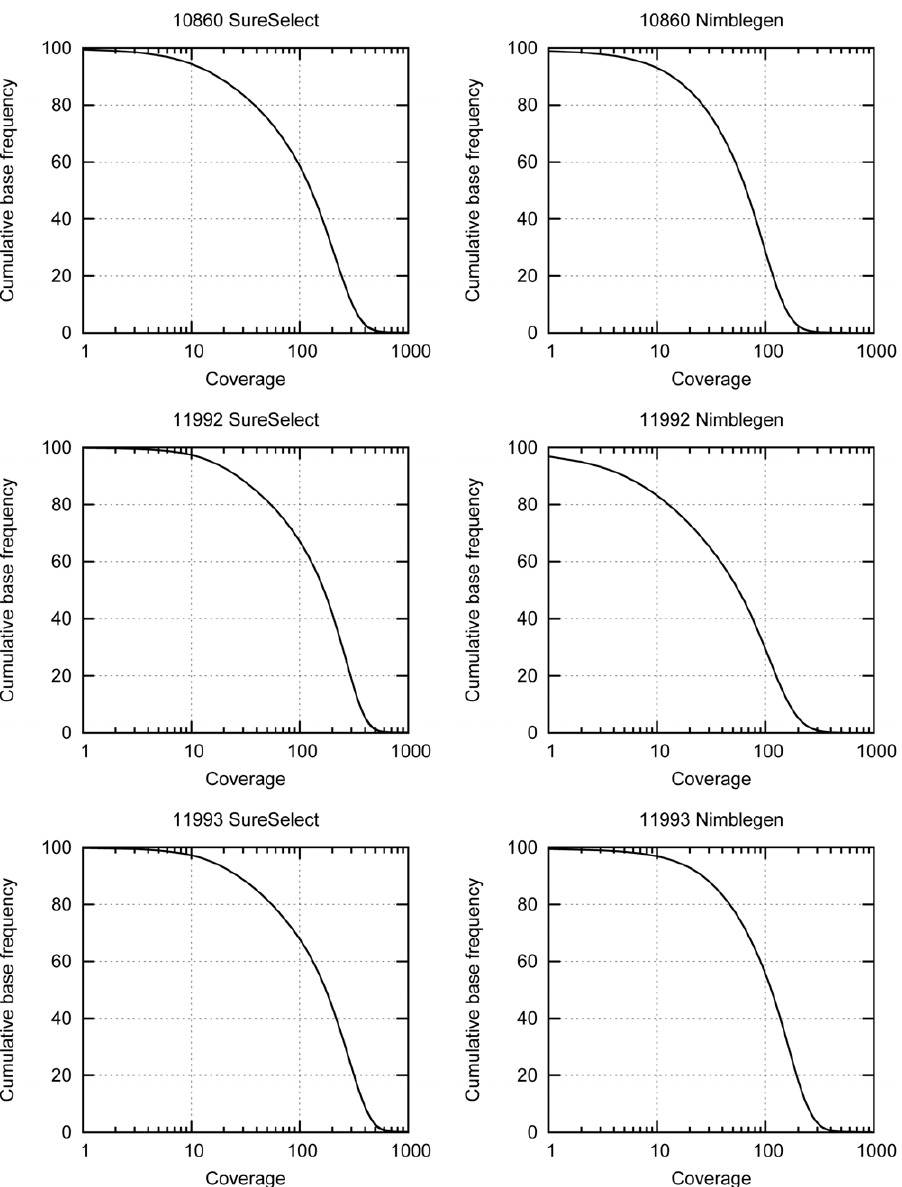
Figure 1. Coverage plots of the sequencing libraries prepared with SureSelect (left) and Nimblegen (right) methods. Cumulative base frequency is plotted against coverage. In the SureSelect libraries, 94–97% of the bases in the regions targeted by the probes are covered by at least ten reads. In the Nimblegen libraries the corresponding number is 83–97%.